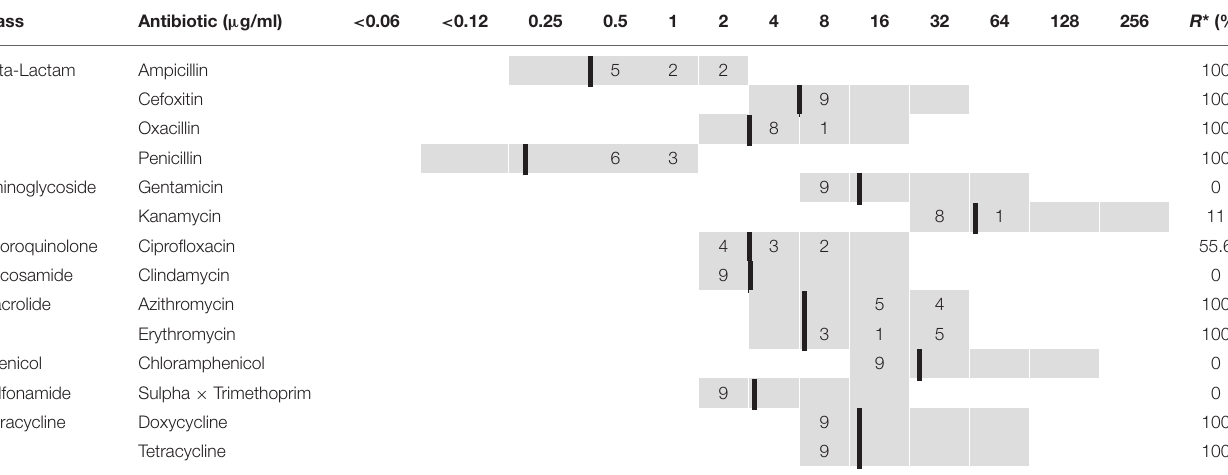
TABLE 2 | Antibiotic susceptibility testing of 9 S. aureus isolated from broilers to 14 antimicrobial agents using agar gel diffusion test. Class Antibiotic ( µ g/ml)